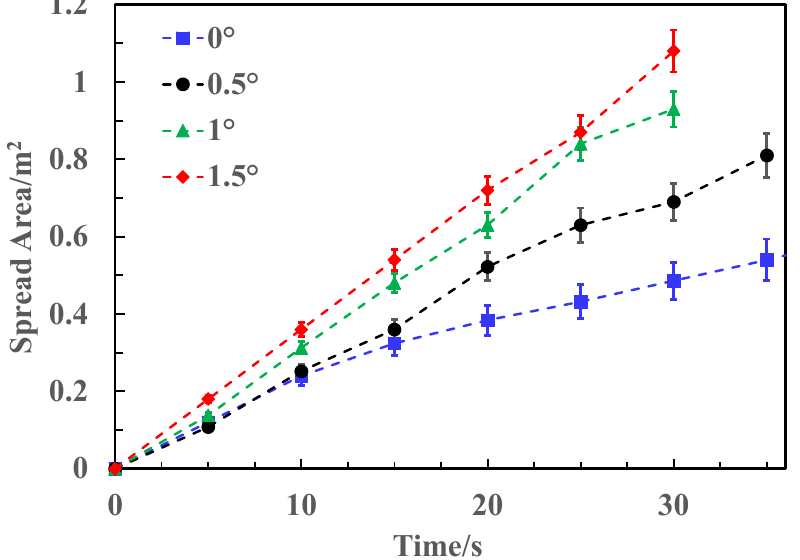
Figure 11. Variation of n-heptane spread rate with a slope on a non-ignition condition.